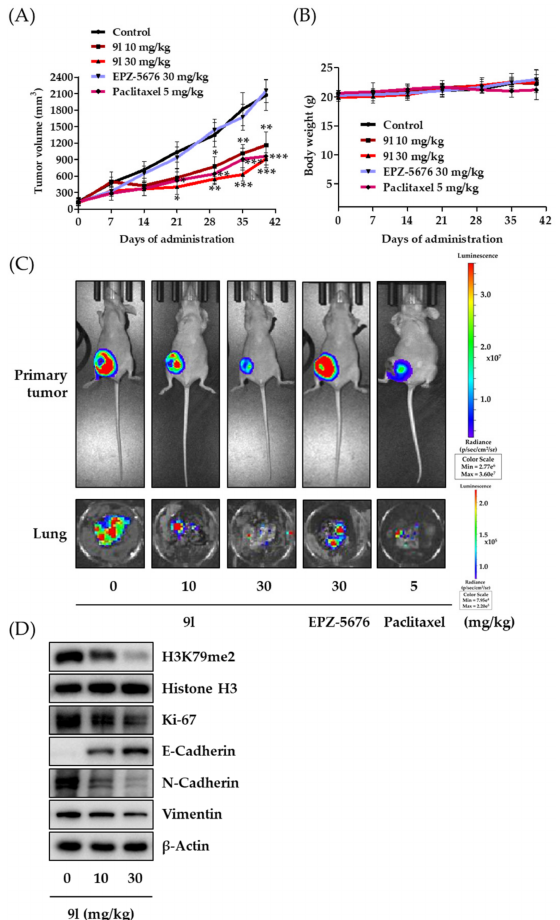
Figure 7. Inhibitory activity of 9l on tumor growth and pulmonary metastasis in an orthotopic mouse model, implanted with MDA-MB-231/Luc cells. ( A ) MDA-MB-231/Luc cells (1 × 10 7 cells/mouse) were injected orthotopically into the fourth fat pad of female BALB/c nude mice. 9l (10 or 30 mg/kg body weight), EPZ-5676 (30 mg/kg body weight), or paclitaxel (5 mg/kg body weight) were administered intraperitoneally, three times a week for 38 days. Tumor volumes were measured every seven days using an electronic caliper. * p < 0.05, ** p < 0.01 and *** p < 0.001 were compared with the vehicle-administered control group. ( B ) Mice body weights were measured to assess general toxicity. ( C ) Luciferase activity imaging of BALB/c nude mice on the last day of the experiment. The lungs of the mice from each study group were excised at the termination of the experiment and imaged using IVIS. ( D ) Small portions of tumor from each group were homogenized in complete lysis buffer (Active Motif), and the protein expression levels of H3K79me2, Ki-67, E-cadherin, N-cadherin, and vimentin were determined via western blotting. Histone H3 and β -actin were used as internal